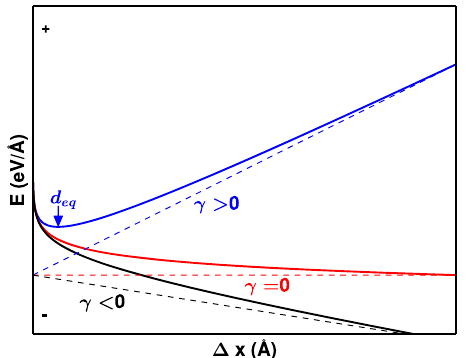
Fig. 2 The schematic change in energy during the dissociation of a lattice dislocation. Total energy ( E ) is shown as a function of the partial dislocation separation distance ( Δ x ) during the dissociation of a lattice dislocation into Shockley partial dislocations. The total energy is the sum of the interaction energy from the elastic strain around the dislocations, and the interaction energy from creating stacking fault. Here the blue, red and black solid lines correspond to the in fl uence of positive, zero, and negative SFE. The sign of the SFE ( γ ) dominates the energy curve as the separation